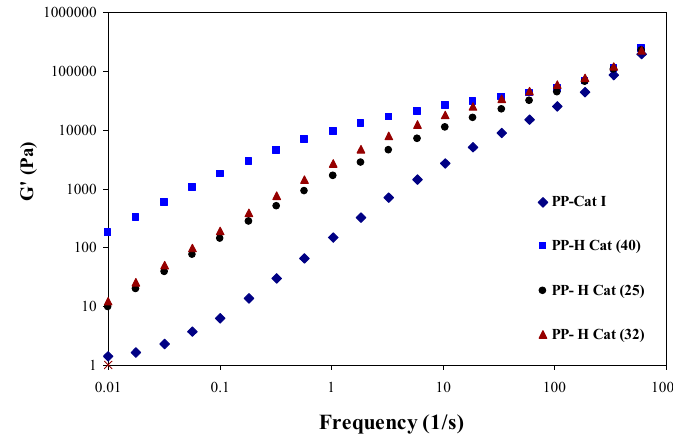
Figure 4. Storage modulus versus frequency for the PP reactor blends synthesized using binary metallocene catalysts at different molar ratios.